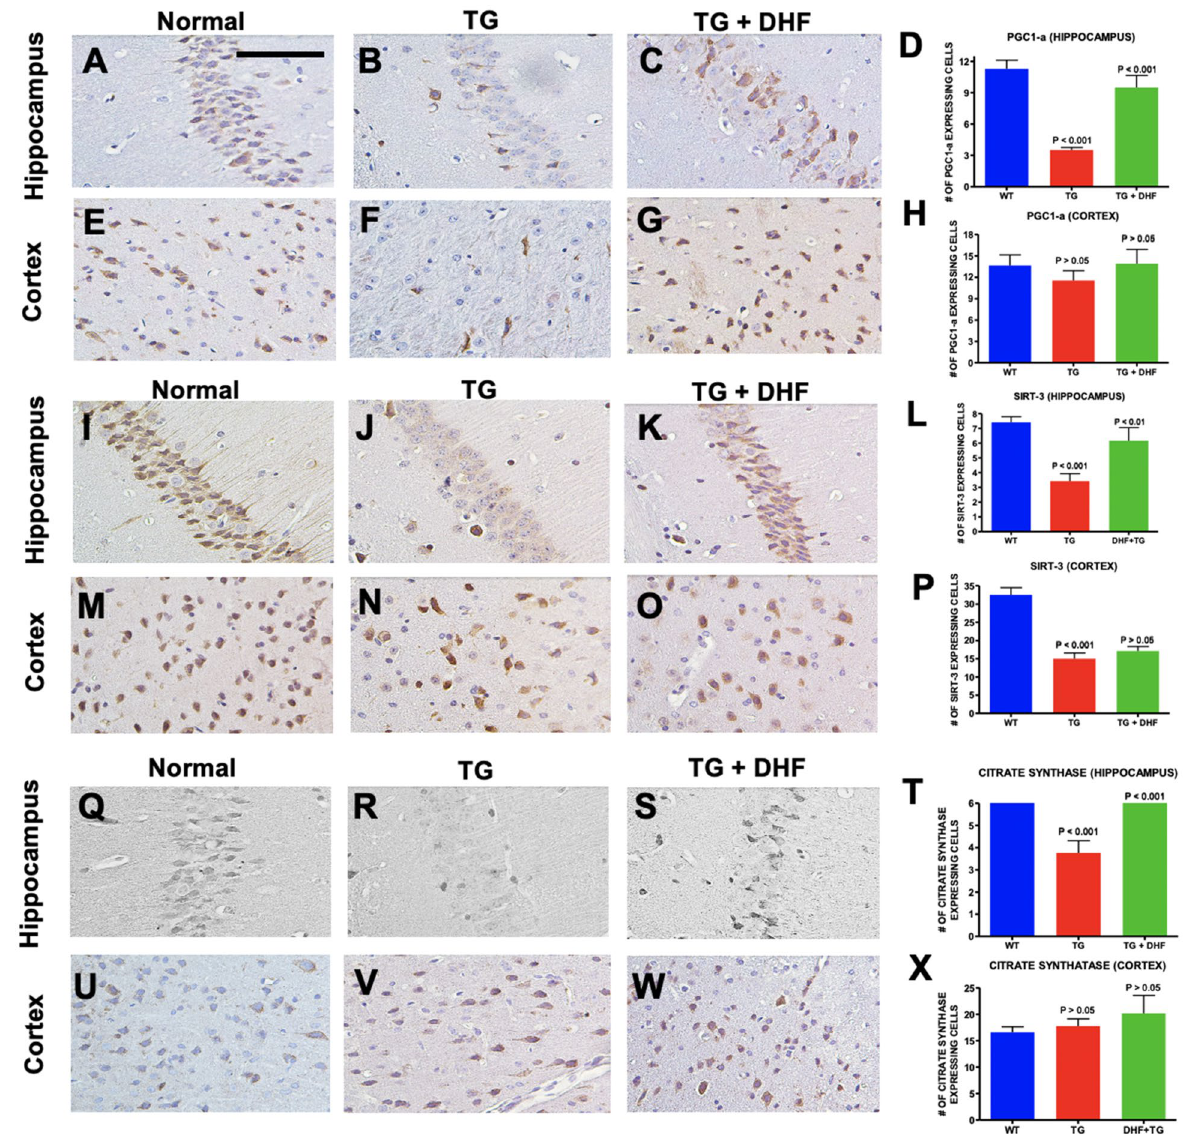
Figure 6. DHF Treatment ameliorated mitochondrial dysfunction and biogenesis. Legend: PGC1a, SIRT-3 and Citrate Synthase expression in the hippocampus and cortex of Wild Type (WT), Tg26, and DHF treated Tg26 mice ( A – X ). Immunohistochemical stained sections show PGC1a, SIRT-3 and Citrate Synthase expressing cells in the hippocampal and cortex regions of the mice brains. 4 WT mice, 5 Tg26 mice, and 4 TG + DHF mice were used. A, B, C, E, F, G, I, J, K, M, N, O, Q, R, S, U, V and W are 400 × magnification pictures of the hippocampus and cortex regions of the mice. ( D ) Quantification of PGC1-a expressing cells in the hippocampus: p < 0.001, WT versus Tg; p < 0.001, Tg versus Tg + DHF. ( H ) Quantification of PGC1-a expressing cells in cortex: p > 0.05, WT versus Tg; p > 0.05, Tg versus Tg + DHF. ( L ) Quantification of SIRT-3 expressing cells in the hippocampus: p < 0.001, WT versus Tg; p > 0.01, Tg versus Tg + DHF. ( P ) Quantification of SIRT-3 expressing cells in cortex: p < 0.001, WT versus Tg; p > 0.05, Tg versus Tg + DHF. (T) Quantification of Citrate Synthase expressing cells in hippocampus: p < 0.01, WT versus Tg; p < 0.01, Tg versus Tg + DHF. ( X ) Quantification of Citrate Synthase expressing cells in cortex: p > 0.05, WT versus Tg; p > 0.05, Tg versus Tg + DHF. The total numbers